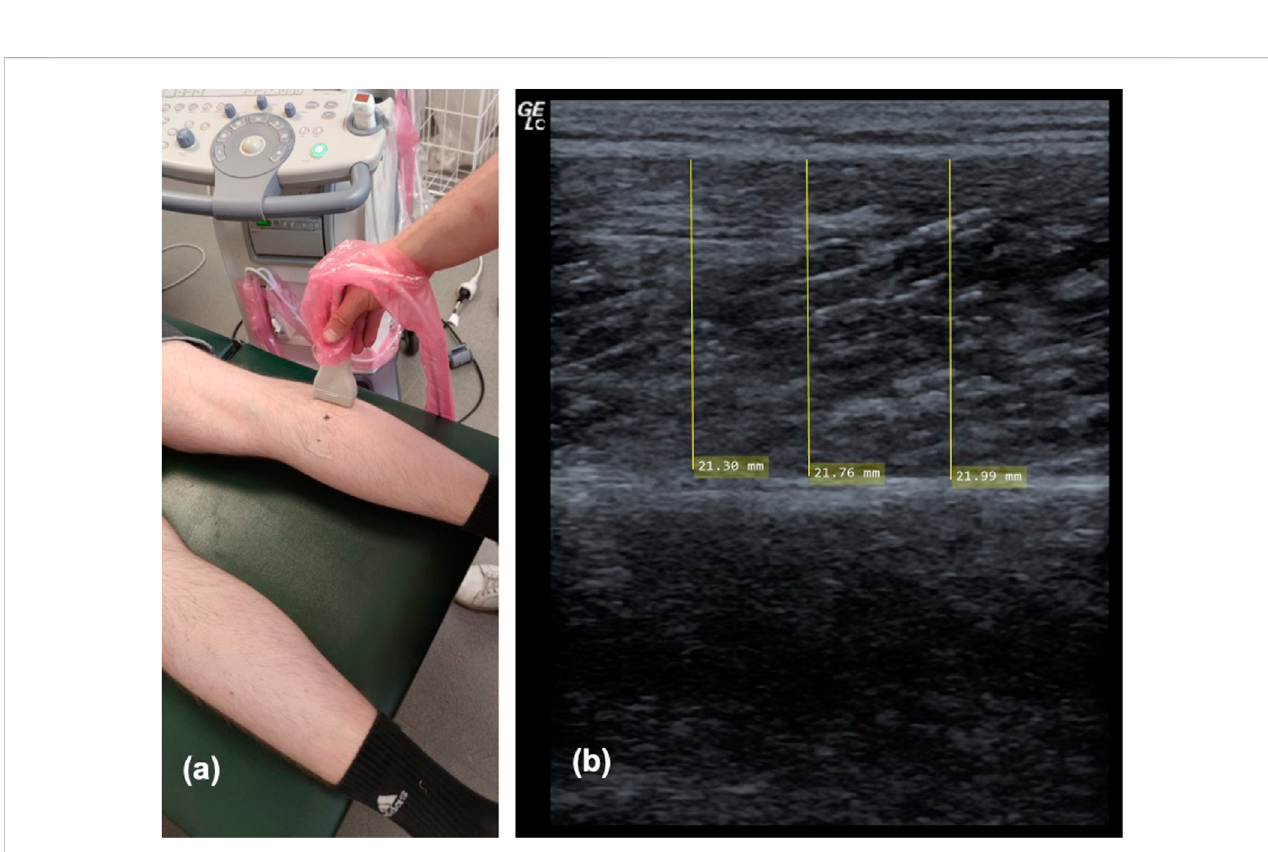
FIGURE 4 Showing ultrasound procedure on the lateral head of the gastrocnemius (A) and one example of sonography measurement of the medial head of the gastrocnemius (B) .